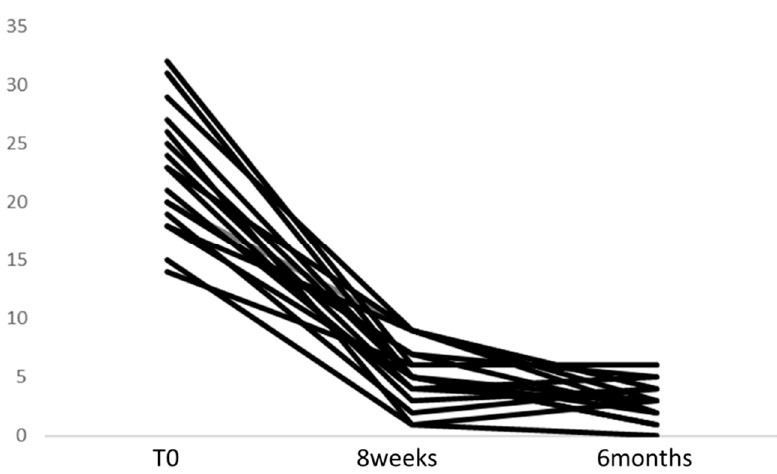
Figure 1. The HAMD score trajectory of each MDD case. Each line presents the change the HAMD score at baseline, 8 weeks, and 6 months after starting antidepressants.